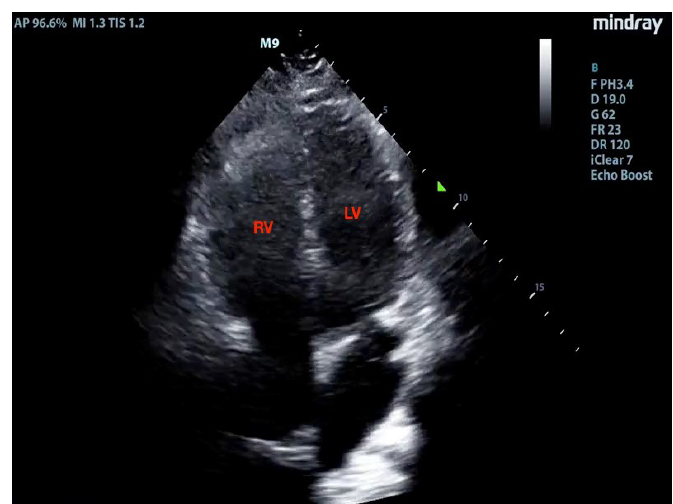
Image 2. Apical four-chamber view of the heart, demonstrating an enlarged right ventricle (RV), greater in size than the left